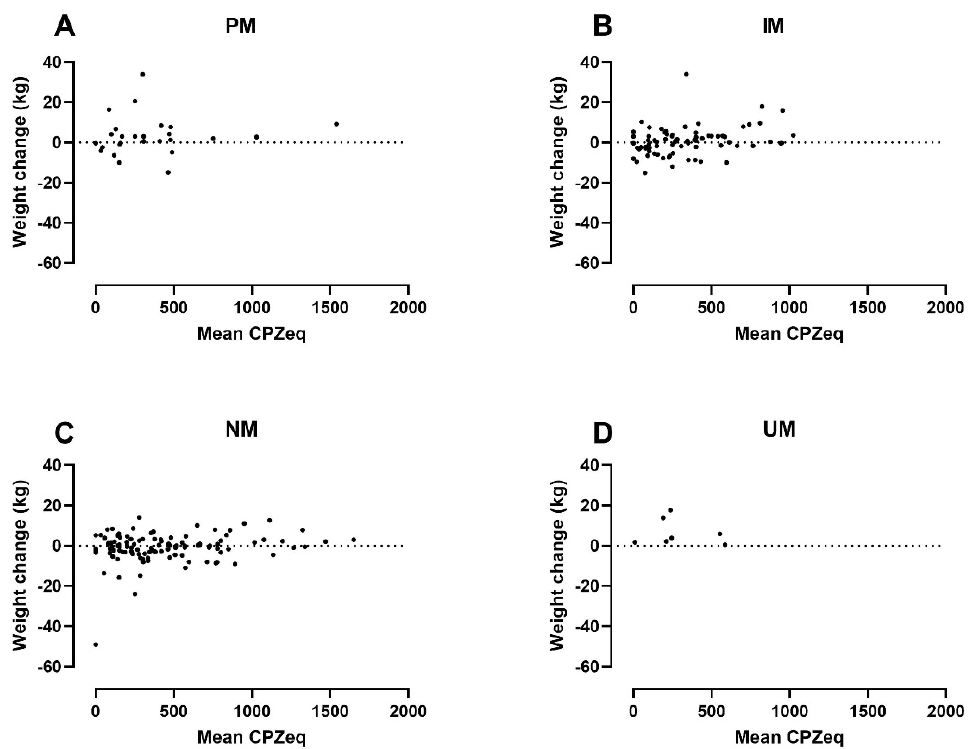
Figure 3. Weight change by average daily exposure to antipsychotics and CYP2D6 genotype in: PMs (=Poor metabolizers) ( A ); IMs (=Intermediate metabolizers) ( B ); NMs (=Normal metabolizers) ( C ) and; UMs (=Ultrarapid metabolizers) ( D ). CPZeq = Chlorpromazine equivalents. Table 5. Multiple linear regression and relative weight